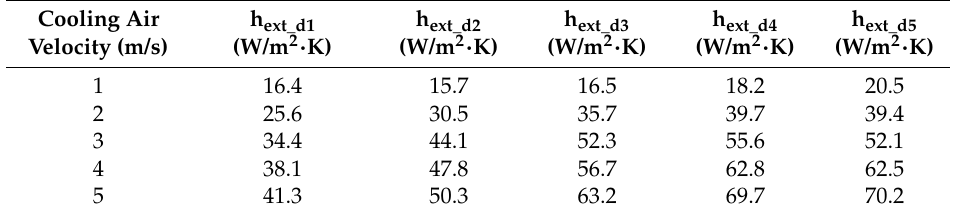
Table 3. Heat transfer coefficient for the air velocities analyzed (results are presented graphically in Figure